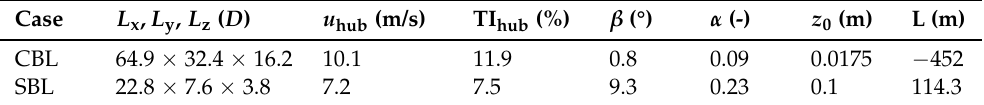
Table 1. Setup of the two LES simulations and the results at the end of the precursor run.